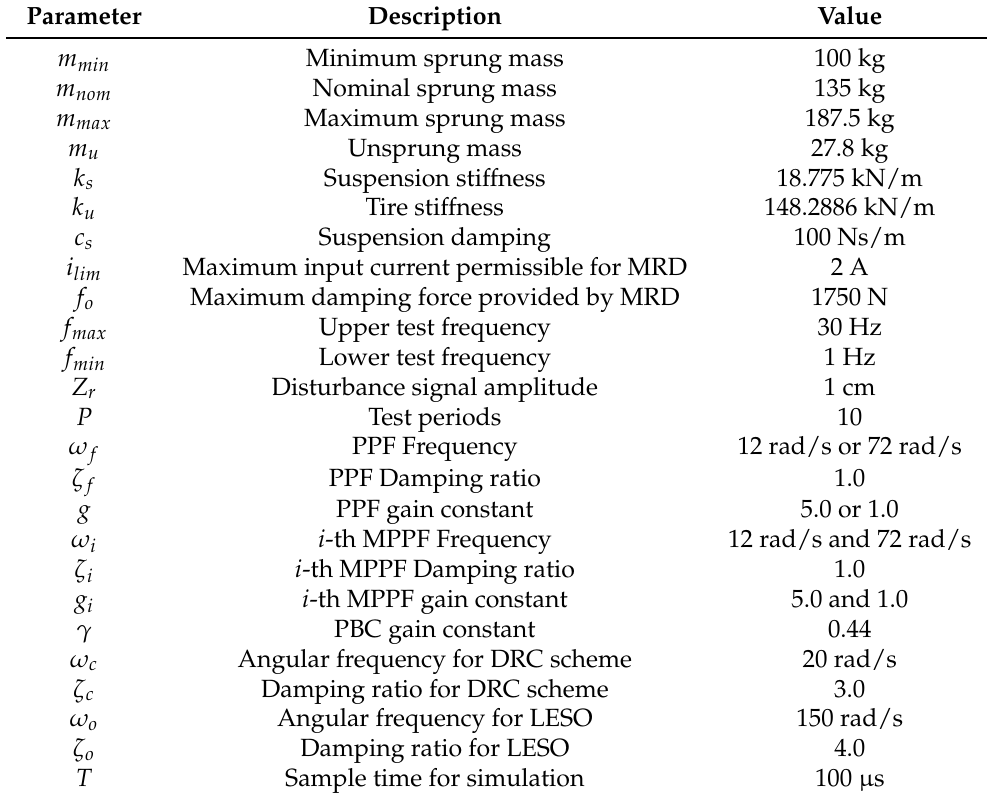
Table 2. Parameters for numerical simulation of the closed-loop system with the proposed controllers.